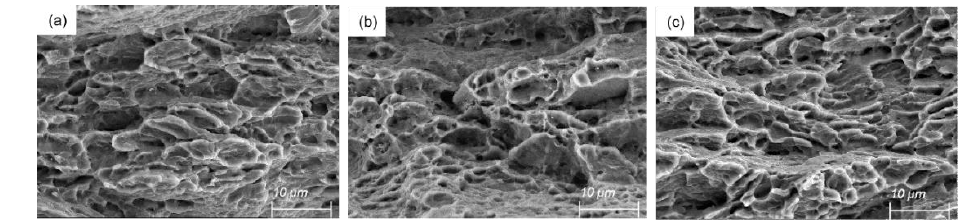
Figure 11. Micro-tensile fracture morphology of asymmetric rolled 1.5 mm plate: ( a ) 45° direction, ( b ) RD direction, and ( c ) TD direction.